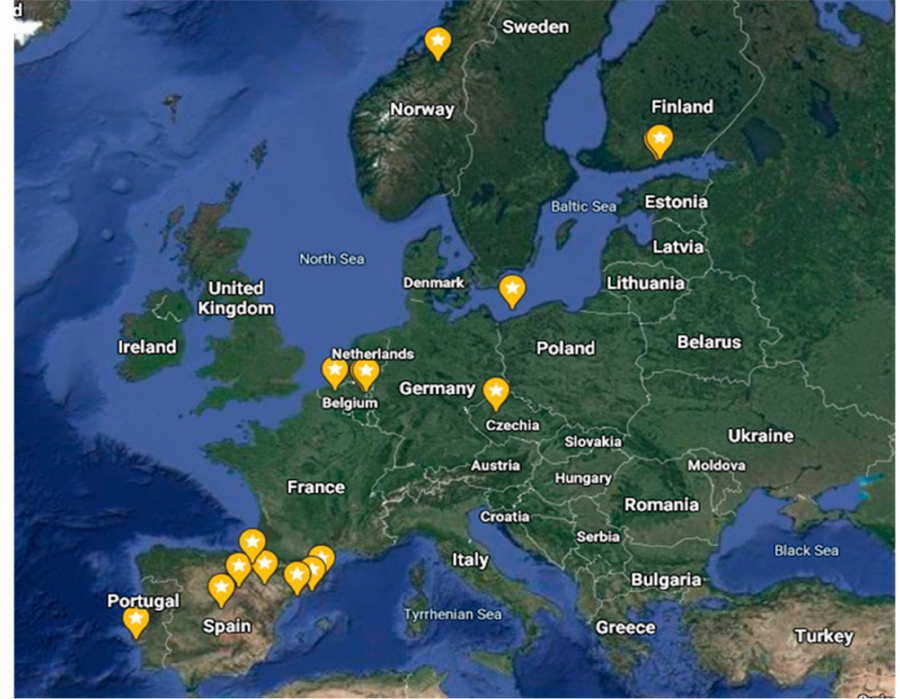
Figure 2. European map highlighting the initial testing facilities studied by module 2 of EERA JP SC [Source: Google